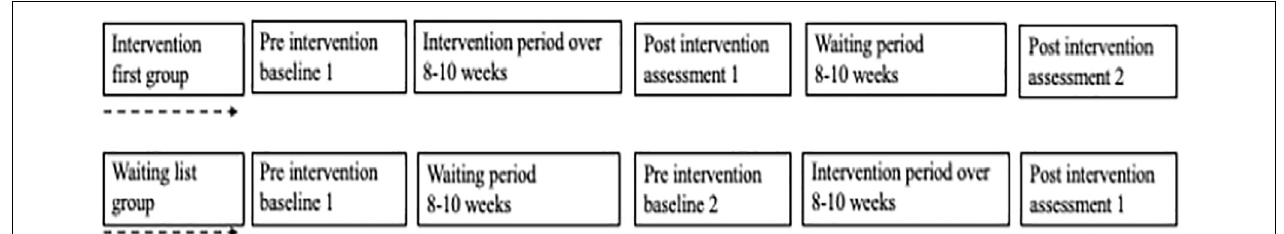
FIGURE 1 | Study design.